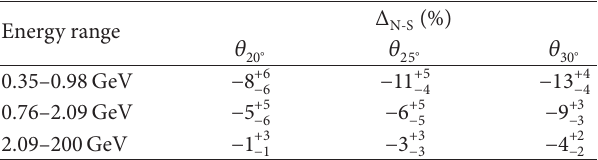
T 4: Percentages of North-South asymmetry of proton intensi- ) as a function of the kinetic energy, using three values for ties ( N-S the extension of the polar regions. Δ